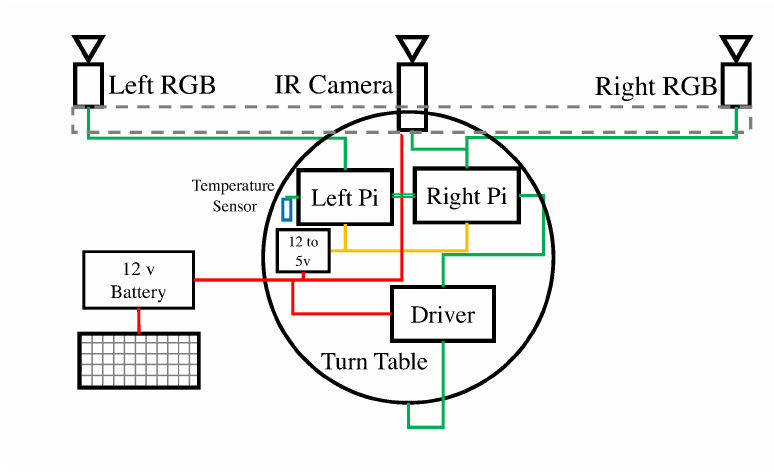
Figure 4. Hardware architecture of the